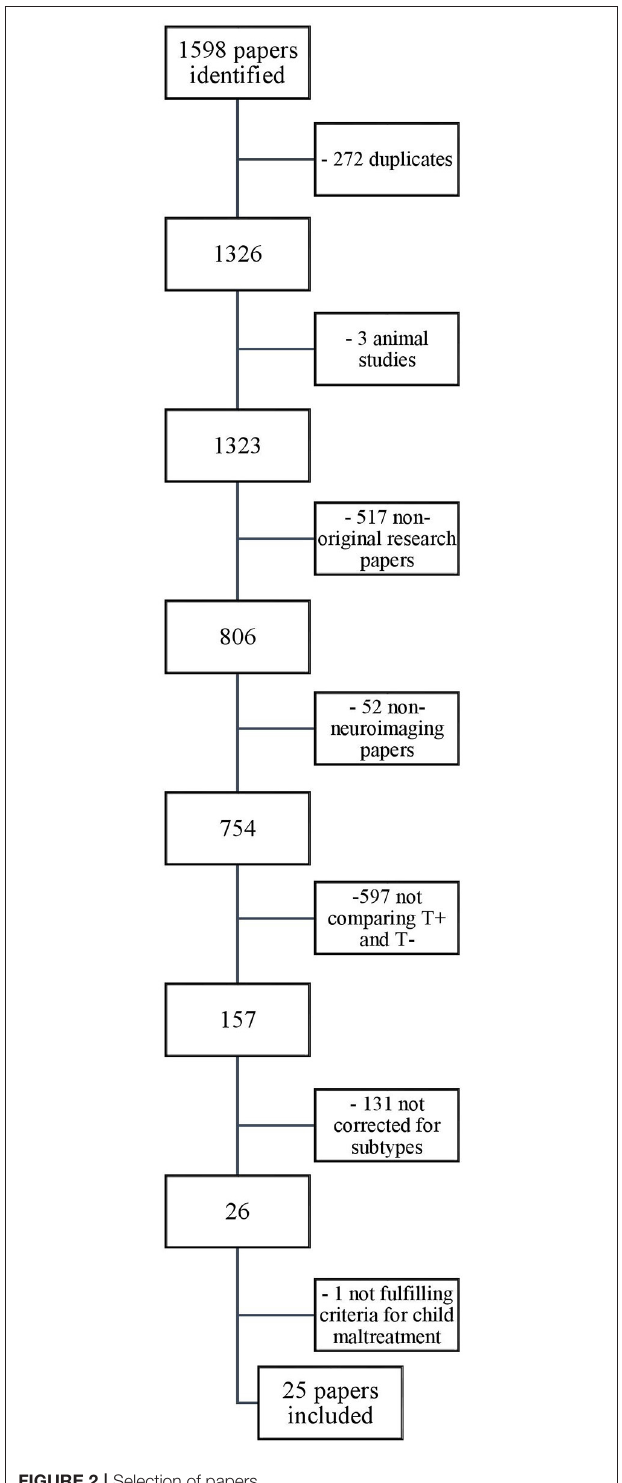
FIGURE 2 | Selection of papers.